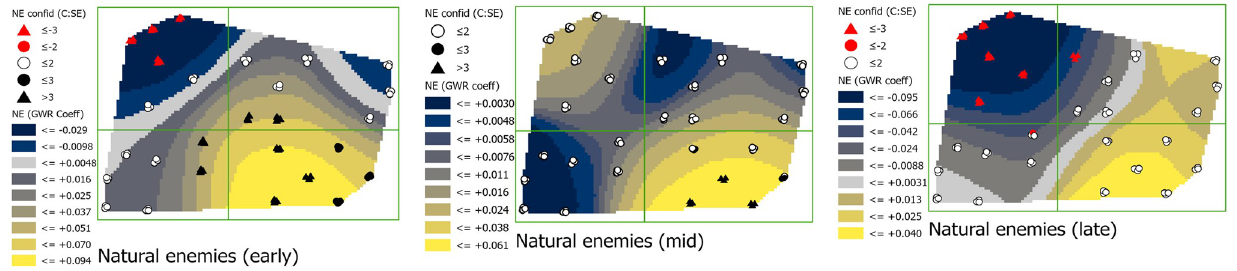
Fig 10. Maps showing early, mid-, and late season natural enemies (INS_NET_1) coefficients with estimations of credence in coefficient values. Coefficient surface values were symbolized using a geometric interval classification scheme from blue to gold, with grey indicating the interval including zero (if present).